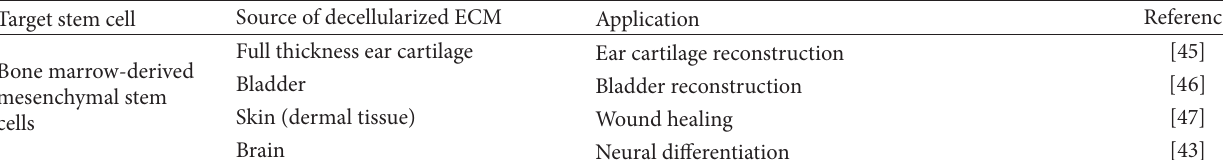
Table 1: Partial list of tissue/organ-derived decellularized ECMs for stem cell